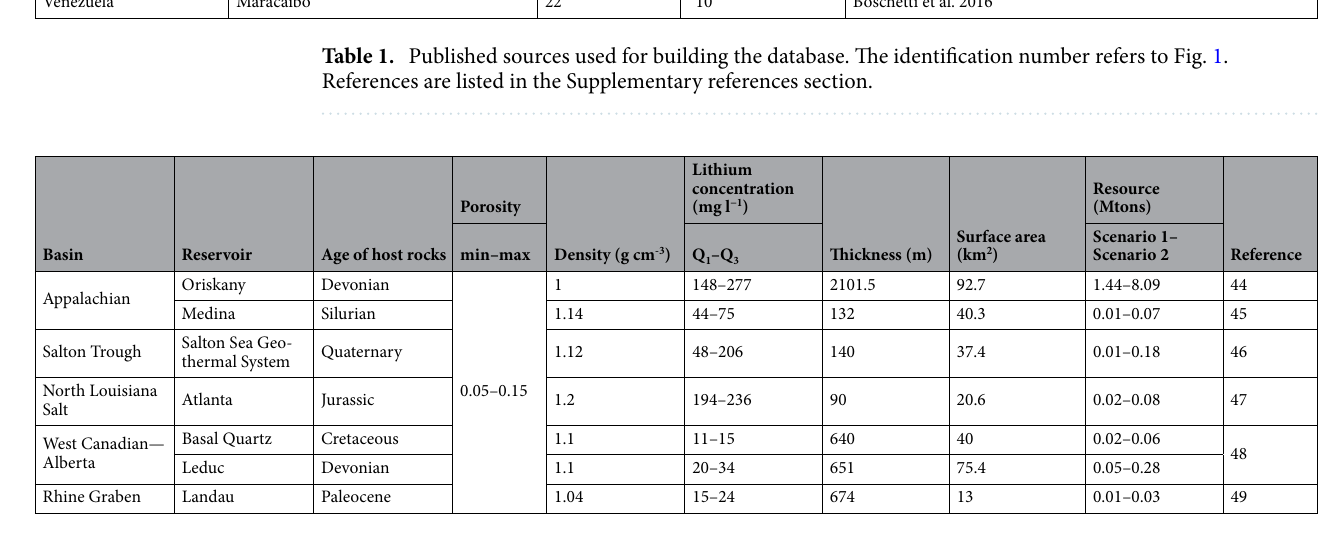
Table 2. Lithium resource estimates for the considered reservoirs. Q 1 and Q 3 : quartiles 1 and 3